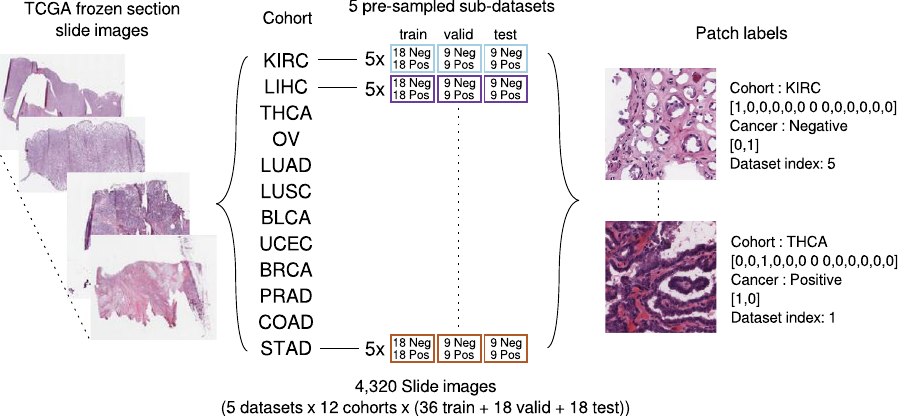
Figure 2. Dataset preparation: a total of 4,320 frozen slide images were used for train/validation/test. Five sub-datasets were constructed for each cohort, with each sub-dataset composed of randomly sampled slides numbering (cancer detection and general cohort discrimination) 18 positive and negative slides or (positive/ negative cohort discrimination) 36 positive or negative slides, with replacement between sub-datasets. Each patch was annotated indicating its cohort, presence of cancer, and sub-dataset index.